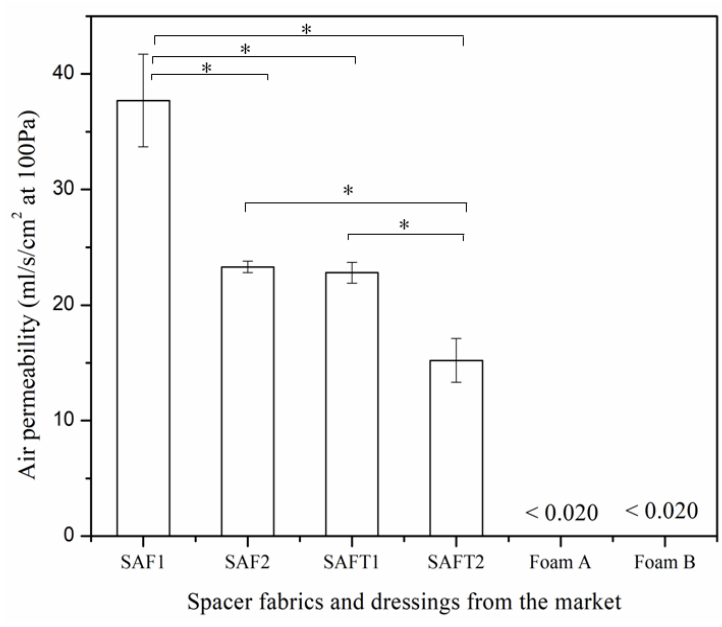
Figure 8. Air permeability of the spacer fabrics and foam dressings from the market. * p < 0.05.